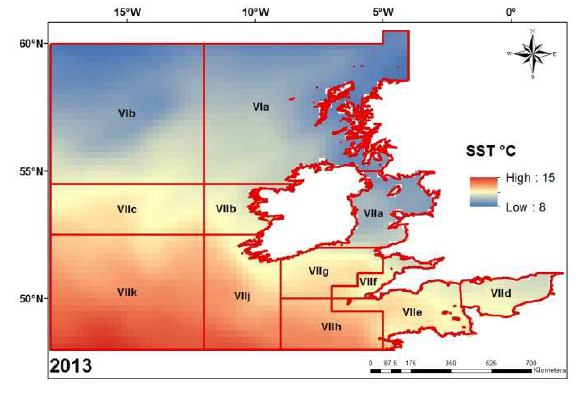
Figure 2. Map of annual SST for